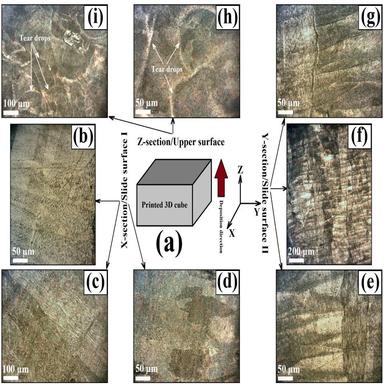
(a) Different sections or surfaces for the LPBF deposited cubic structure. Optical microstructures for (b-d) X-, (e-g) Y-, and (h, i) Z-sections of 3D-printed nanocomposite material at different locations, showing the grain structural heterogeneity/anisotropy for the optimized processing parameters with a hatch space of 200 µm, a laser printing power of 180 W, a scan speed of 90 mm/sec, and a layer thickness of 20 µm.